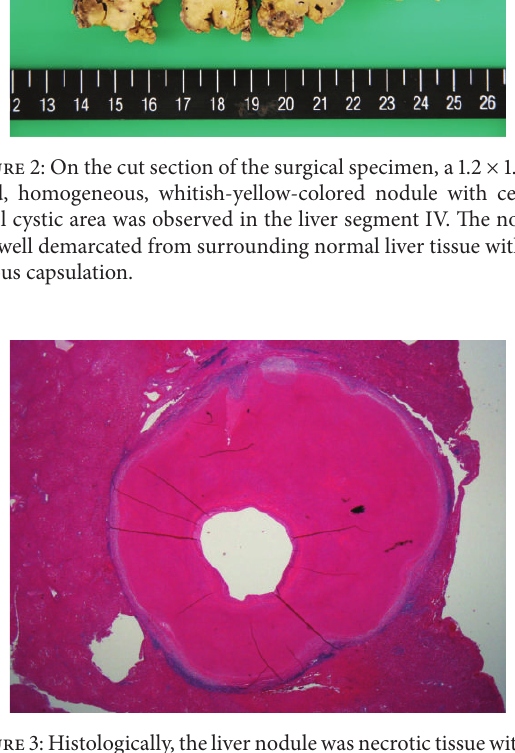
Figure 3: Histologically, the liver nodule was necrotic tissue without viablecellsandsignsofinflammation,whichhadfibrouscapsuleand central cystic